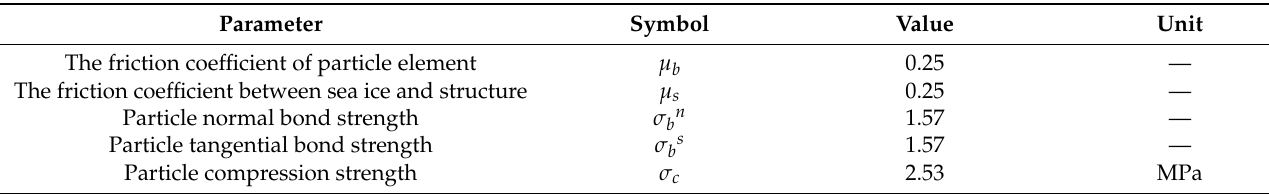
Table 4. Main parameters of sea ice discrete element calculation.